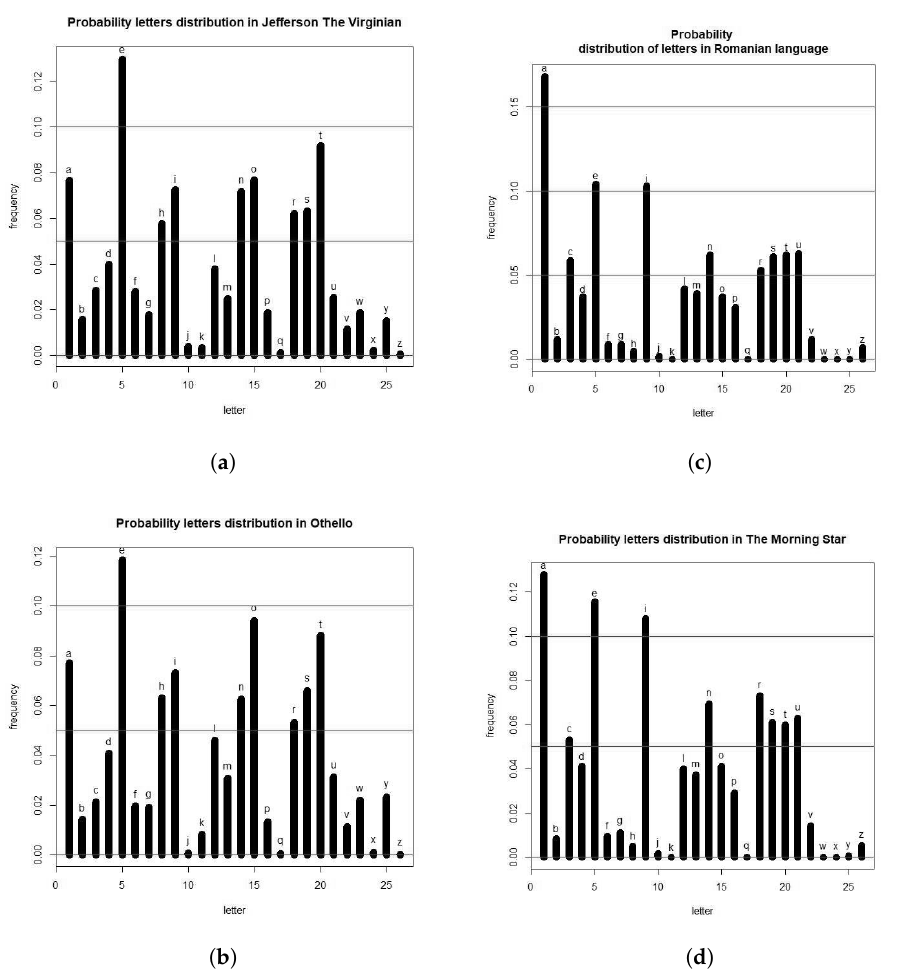
Figure 1. The letter probability distribution for: ( a ). Jefferson the Virgian; ( b ). Othello; ( c ). Memories of Childhood (in Romanian); ( d ). The Morning Star (in Romanian).